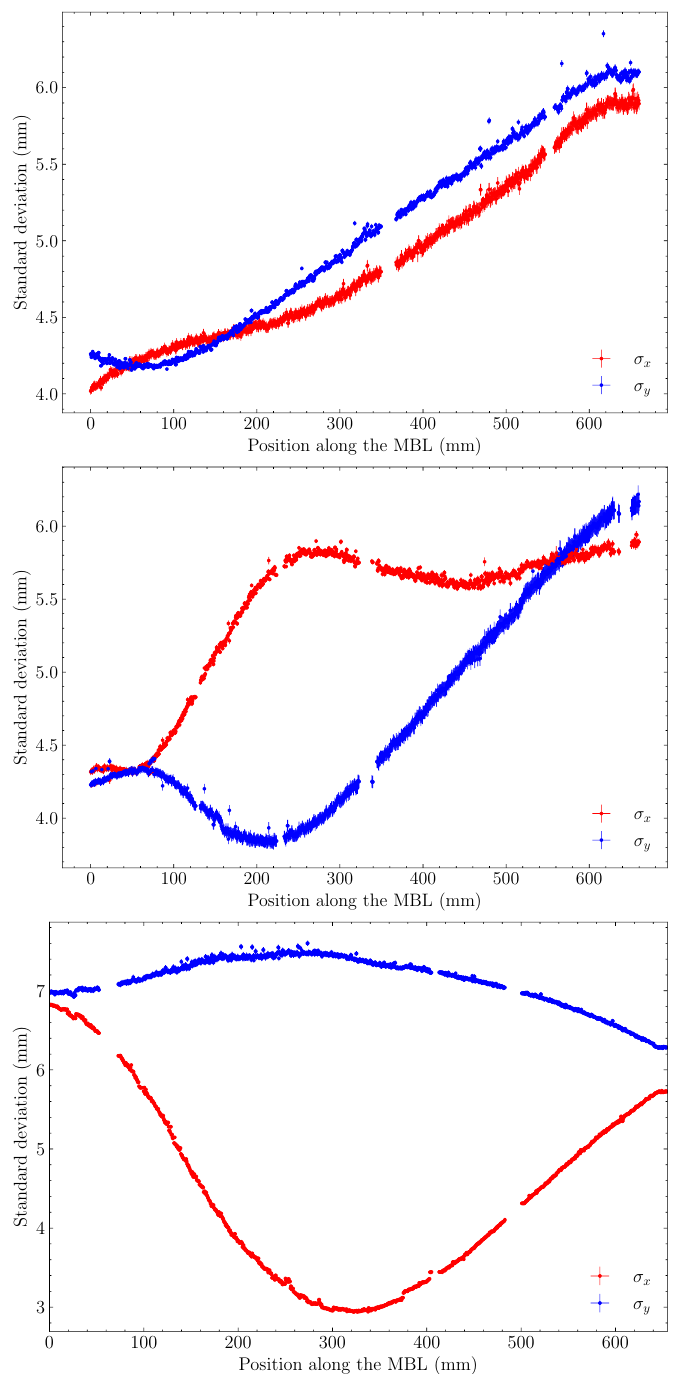
Figure 8. Measured sigma in both horizontal (red) and vertical (blue) planes, along the MBL for the three different cases: MBL magnets off ( top ); a focused beam entering the MBL with magnets on ( center ); a flat beam entering the MBL ( bottom